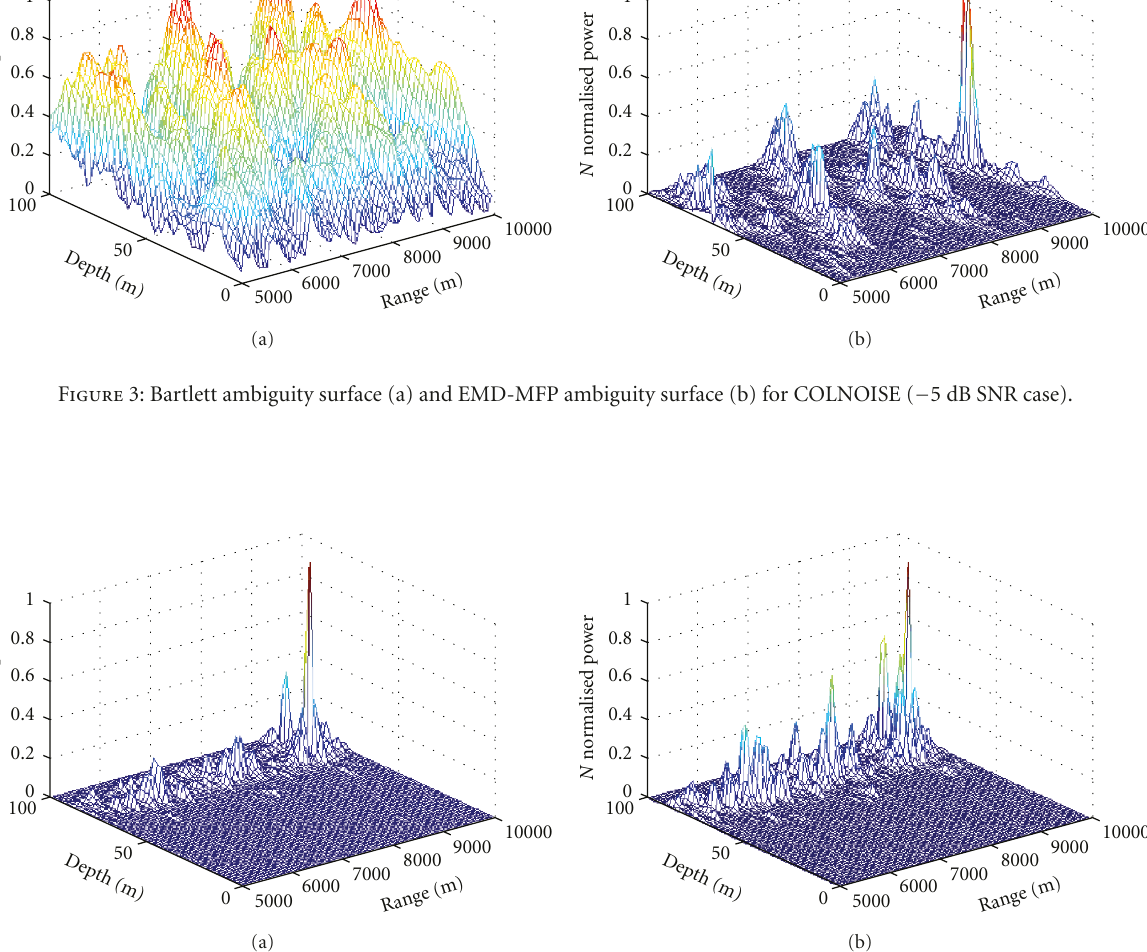
Figure 4: The EMD-MFP ambiguity surface (a) 10 dB SNR case and (b) − 5dB SNR case for